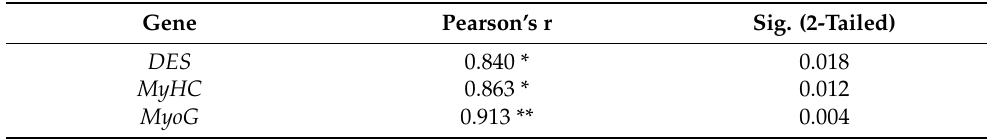
Table 4. Pearson correlation analyses between the expression of HOXA11 and muscle-development- associated genes in differentiation of muscle